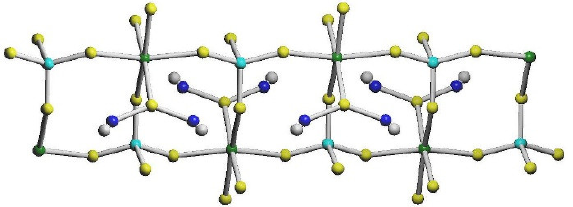
Figure 4. The ladder topology in 2 with Cu(II) in blue, Cu(I) in cyan, nickel in green, thiocyanates in yellow and trien ligands in grey.